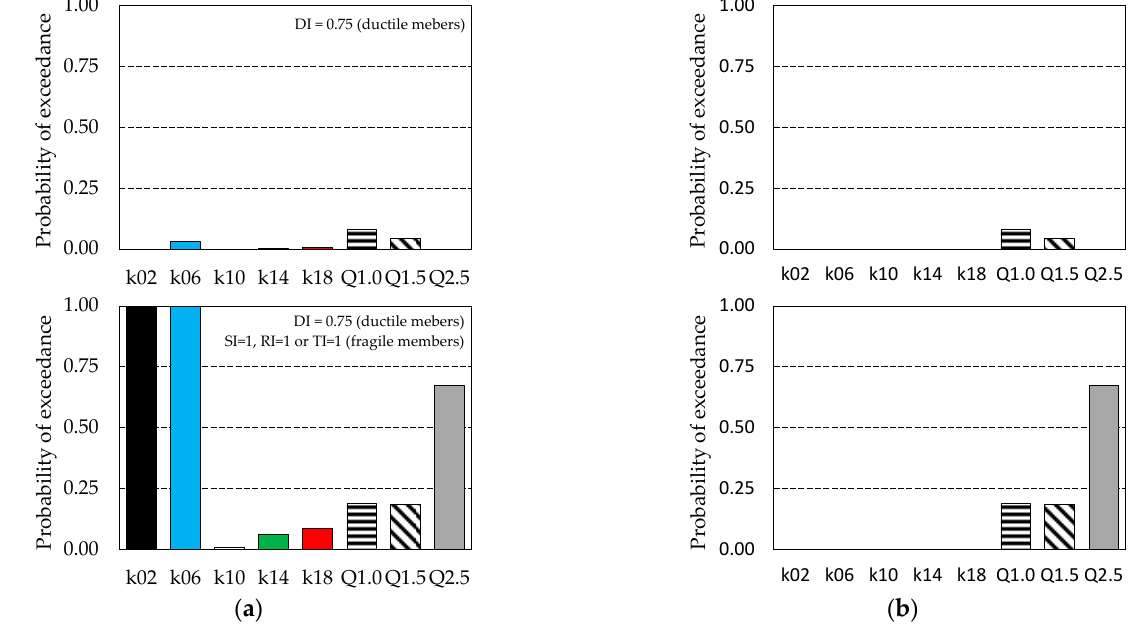
Figure 4. Probability of exceedance of the SD limit state for a g = 0.15 g: ( a ) 4-storey structures; ( b ) 8-storey structures.